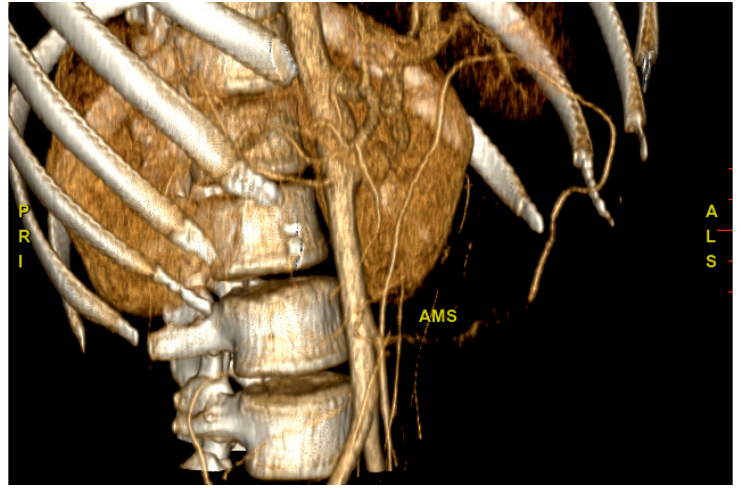
Figure 1. CT scan of the abdomen. Proximal occlusion of the superior mesenteric artery (AMS). According to the EULAR/PRINTO/PRES for childhood Takayasu Arteritis, the diagnosis of Takayasu arteritis (TA) was made [8]. On a rheumatologist’s recommendation, corticosteroid therapy at a high dose (Prednisone 1 mg/kg os QD) was administered. The patient reported clinical benefit; moreover, the near normalization of the inflammatory markers after seven days of therapy was observed. She was then discharged home with further medical